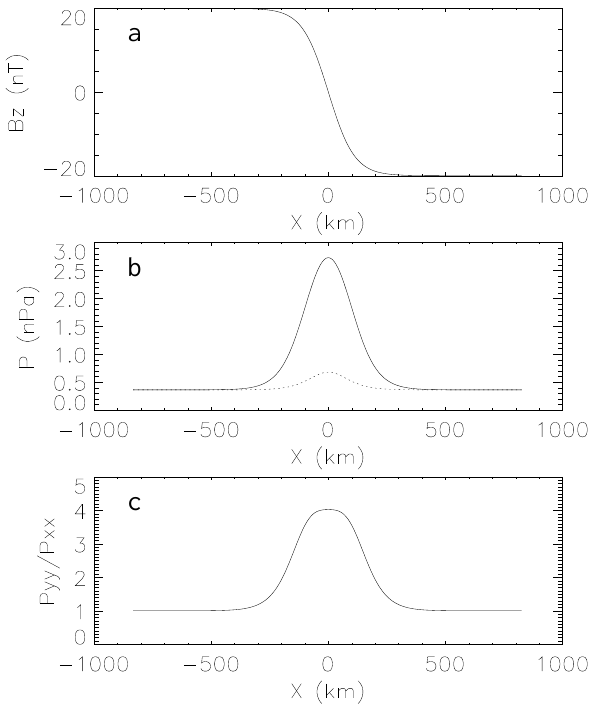
Fig. 1. The spatial dependence of physical parameters associated with a Harris current sheet: ( a ) the magnetic field B z in nano Tesla; ( b ) the pressure p xx = p zz (dashed line) and p yy (continuous line) in nano Pascal; and ( c ) the ratio p yy /p xx = p yy /p zz . The x com- ponent corresponds to the gradient direction, and y and z are tan- gential (it is not the GSM coordinate system). The parameters are inspired from a narrow current sheet crossing seen on board Clus- ter on 14 September 2001, at 23:10UT, interpreted by Petrukovich et al. (2003) as a tangential discontinuity very similar to a Harris current